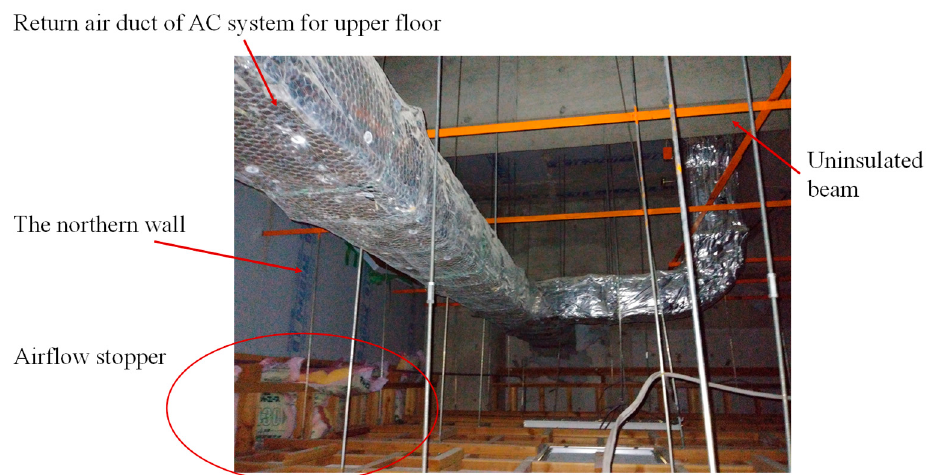
Figure 2. The duct passing through the attic space.